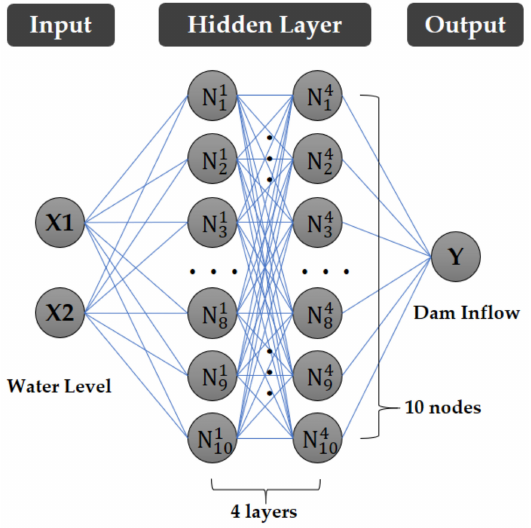
Figure 3. Structure of the